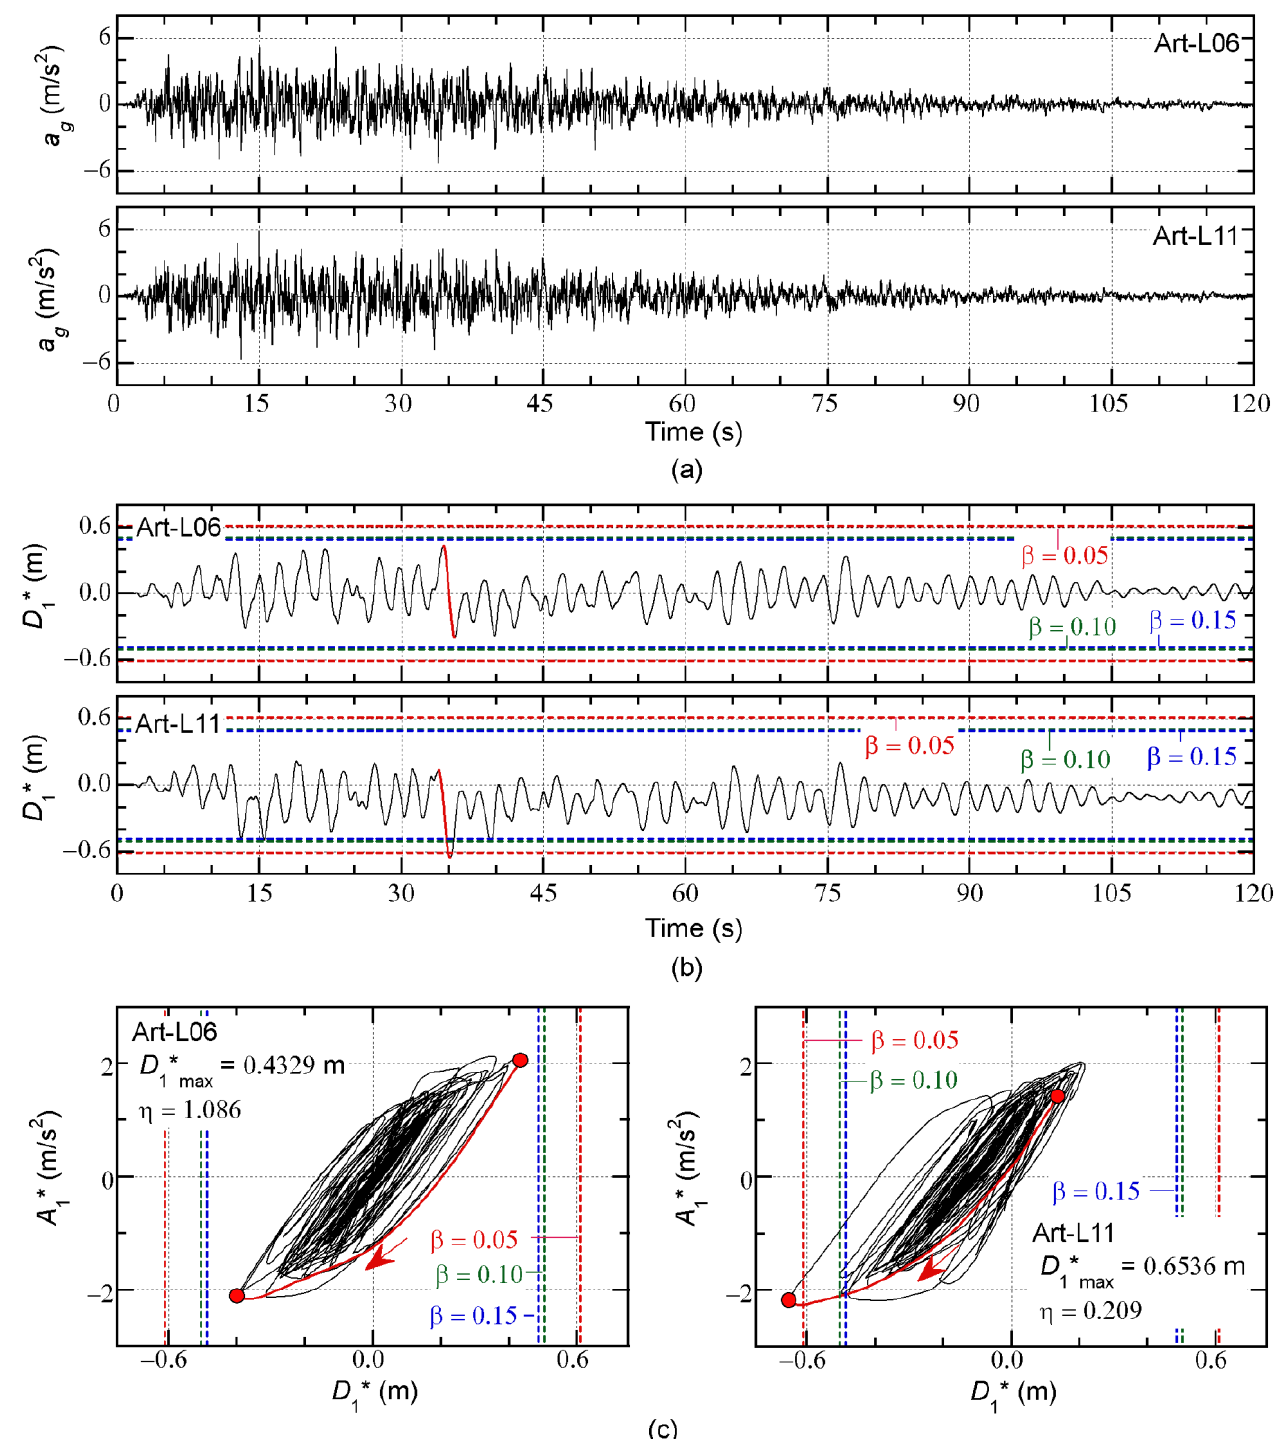
Figure 16. Time-history and hysteresis of the first modal response (16-story model, h 1 f = 0.05, Art-L): ( a ) time-history of ground acceleration; ( b ) time-history of equivalent displacement of the first modal response; ( c ) hysteresis of the first modal response.